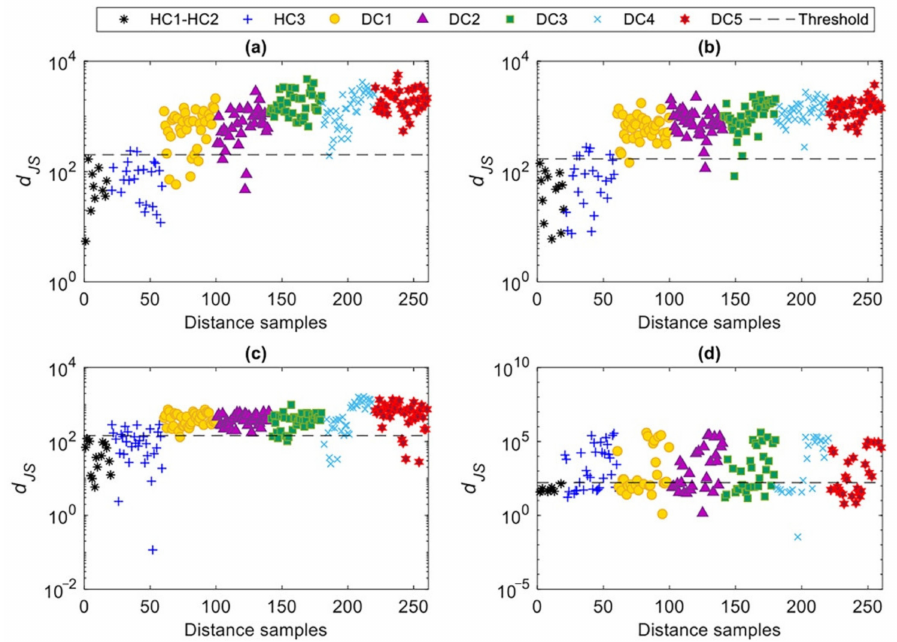
Figure 10. Damage detection by the proposed multi-level machine learning method and PSD: